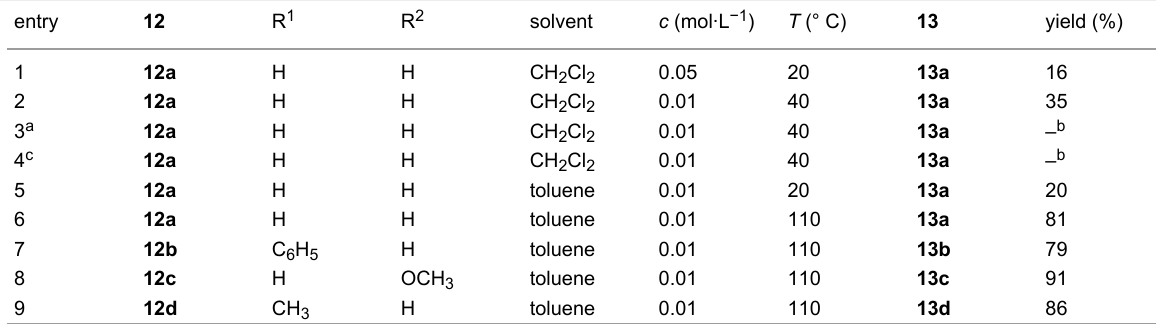
Table 4: Optimization of RCM conditions and synthesis of annellated coumarins 13 .